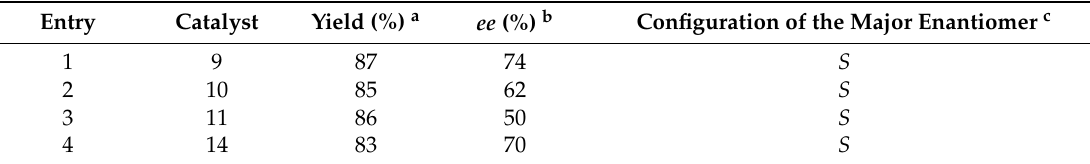
Table 1. Influence of catalyst on the reaction yield and enantioselectivity according to Scheme 4. Entry